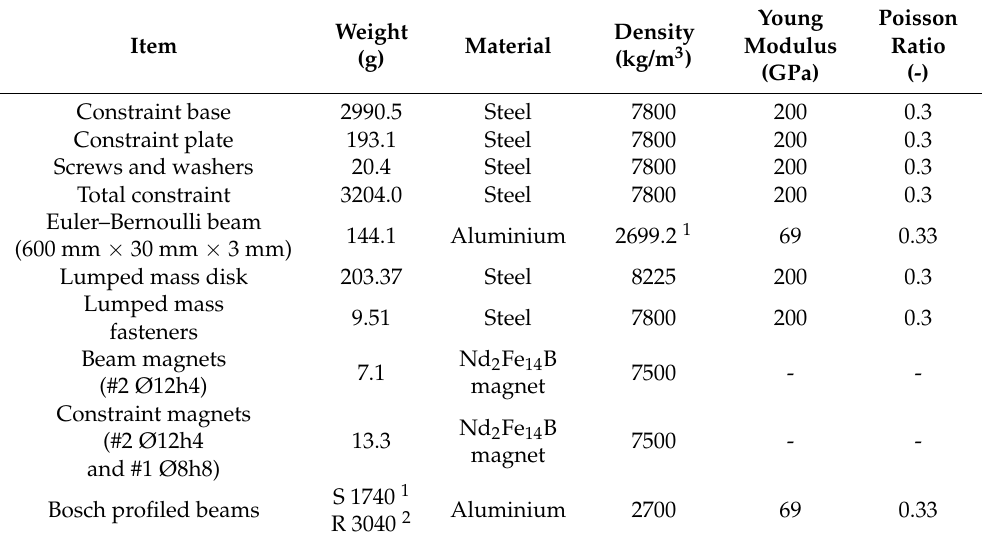
Figure 3. A clamp ( a ) and a non-holonomic constraint in non-contact ( b ) and in contact ( c ). Geometrical and mass properties for beam, clamp, and lumped mass are listed in Table 1. Table 1. Weight and property of experimental setup objects.